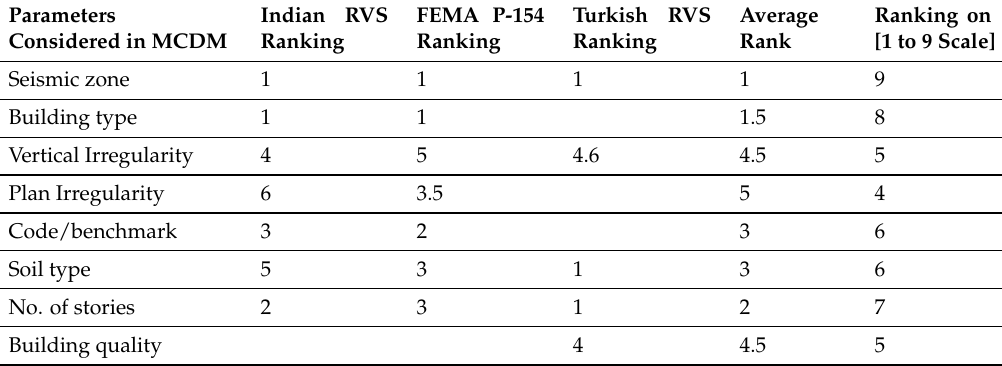
Table 15. Ranking of parameters based on the comparison of methods for ranks scaled from 1 to